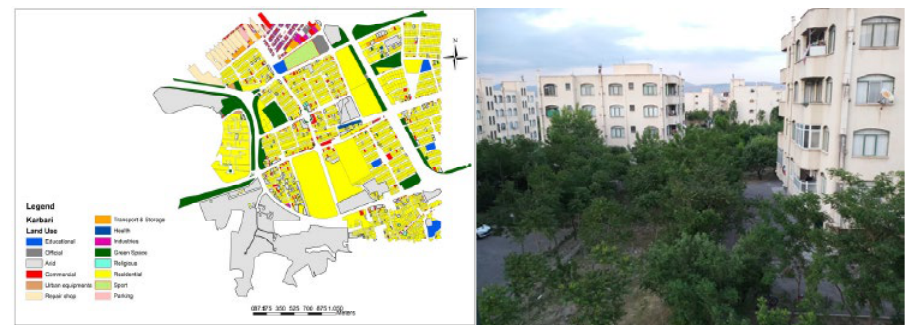
Fig. 2: Land use and distribution of green space in the study area